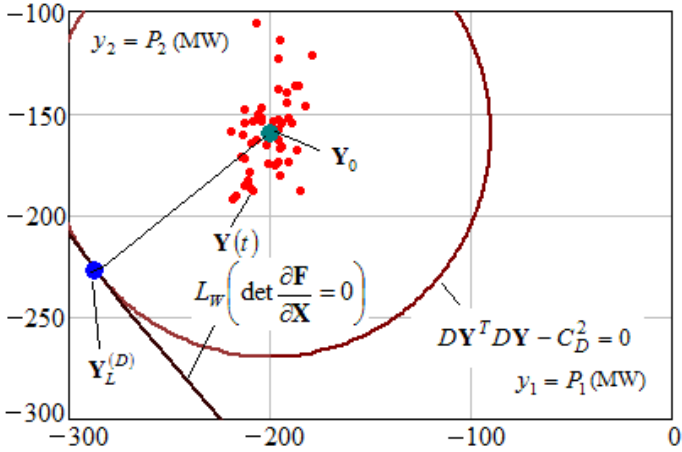
( ) D y ( D ) L 1 = − 287 MW; = − 287 L 1